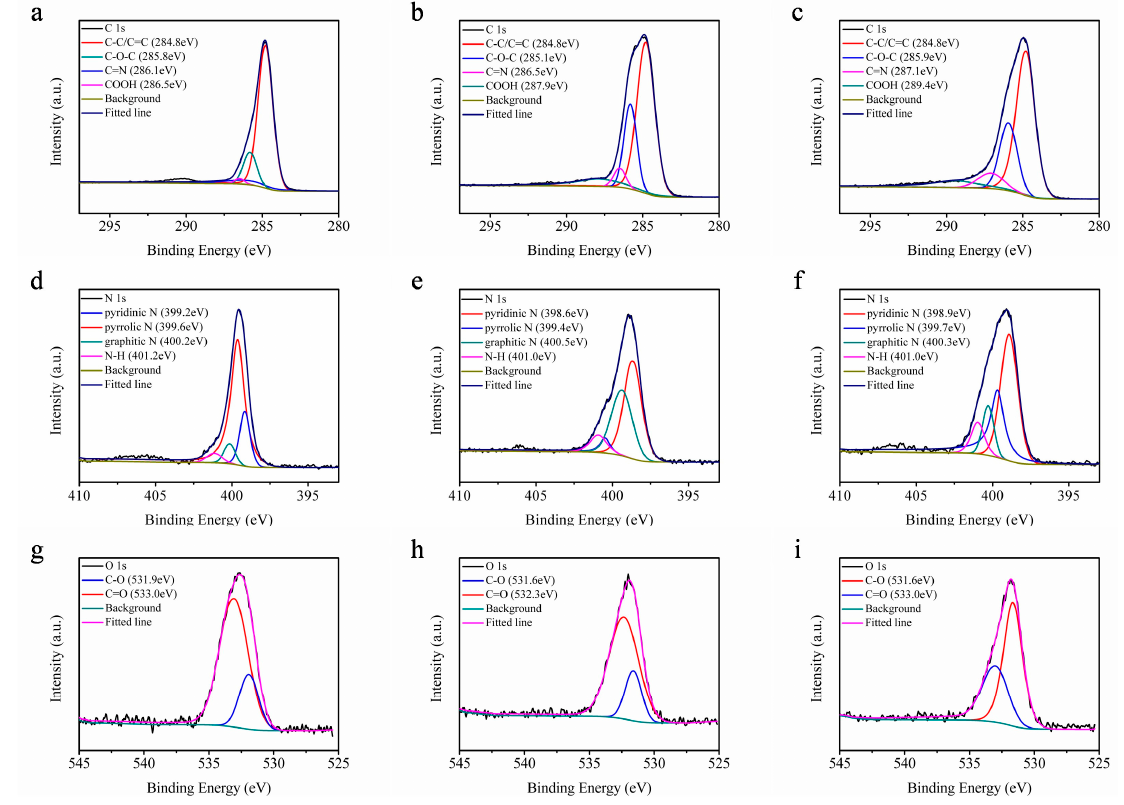
Figure 3. High-resolution XPS C 1s ( a – c ), N 1s ( d – f ) and O 1s ( g – i ) spectra of B-CDs, Y-CDs, and R-CDs.